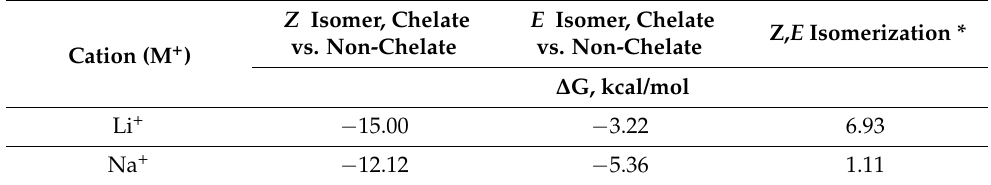
Table 1. Relative Gibbs energies of IQ-1L and IQ-1S E and Z isomers calculated by the DFT method. Z Isomer, Chelate vs. Cation (M + )